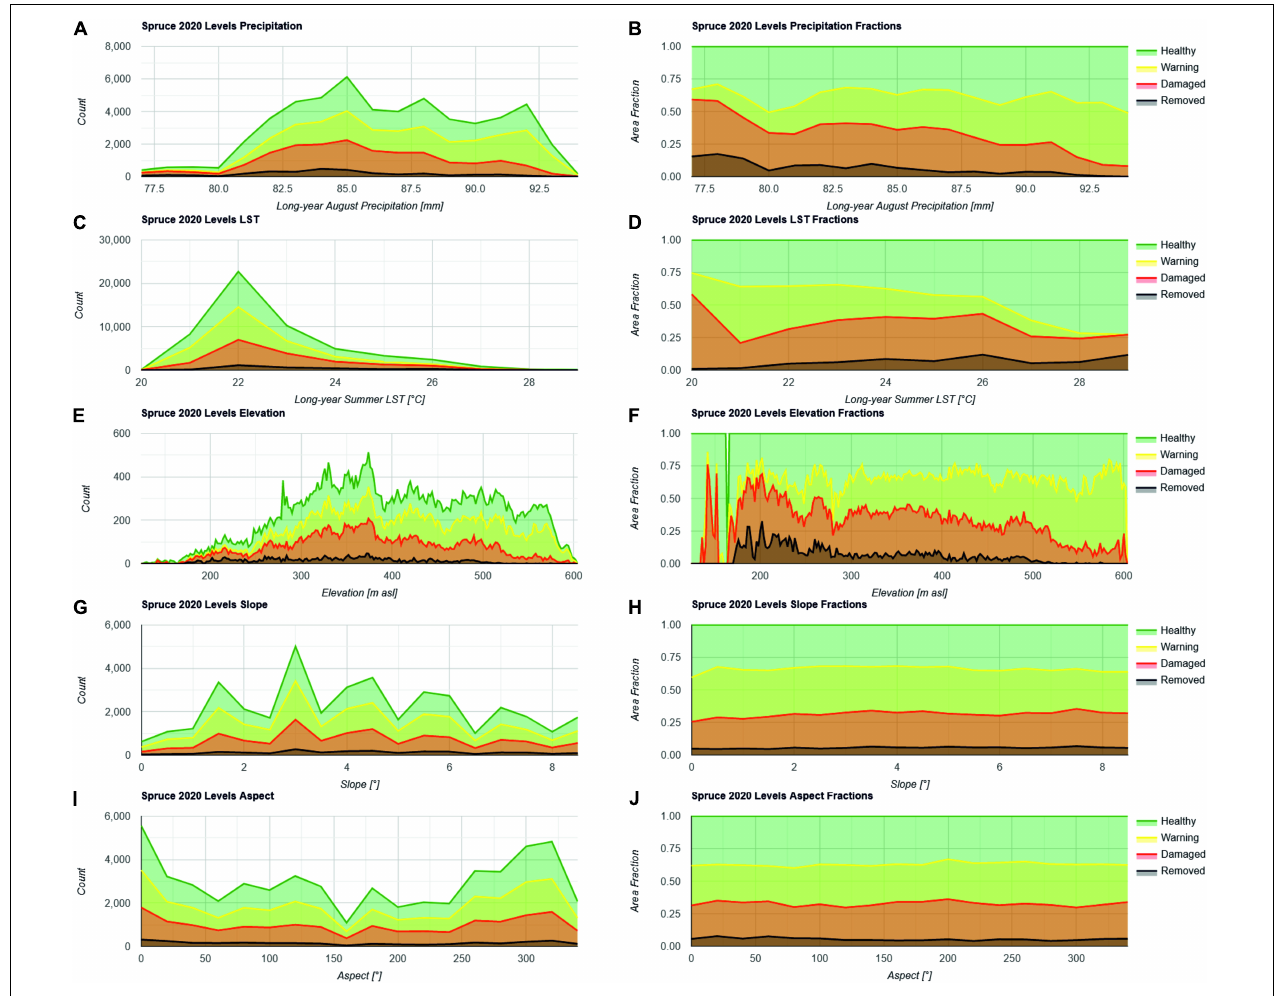
FIGURE 10 | Histograms of spruce health levels expressed in number of pixels showing a specific health level for 2020 in relation to the environmental conditions such as precipitation in August (A,B) summer land surface temperature from June to September 2018–2020 (C,D) elevation (E,F) slope (G,H) and aspect (I,J) . Both absolute pixel counts (left) and relative spruce area fractions (right) are